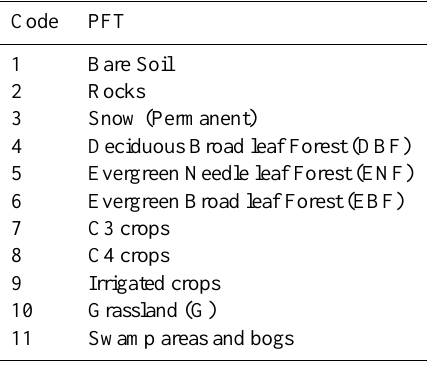
Table 1. List of PFTs defined in ECOCLIMAP-I and used in the land surface model.